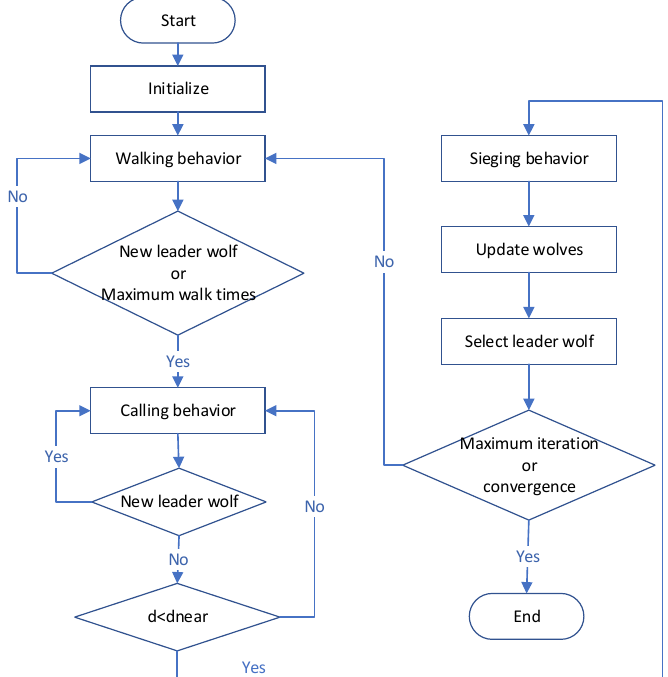
Figure 1. The optimization process of the WPA.